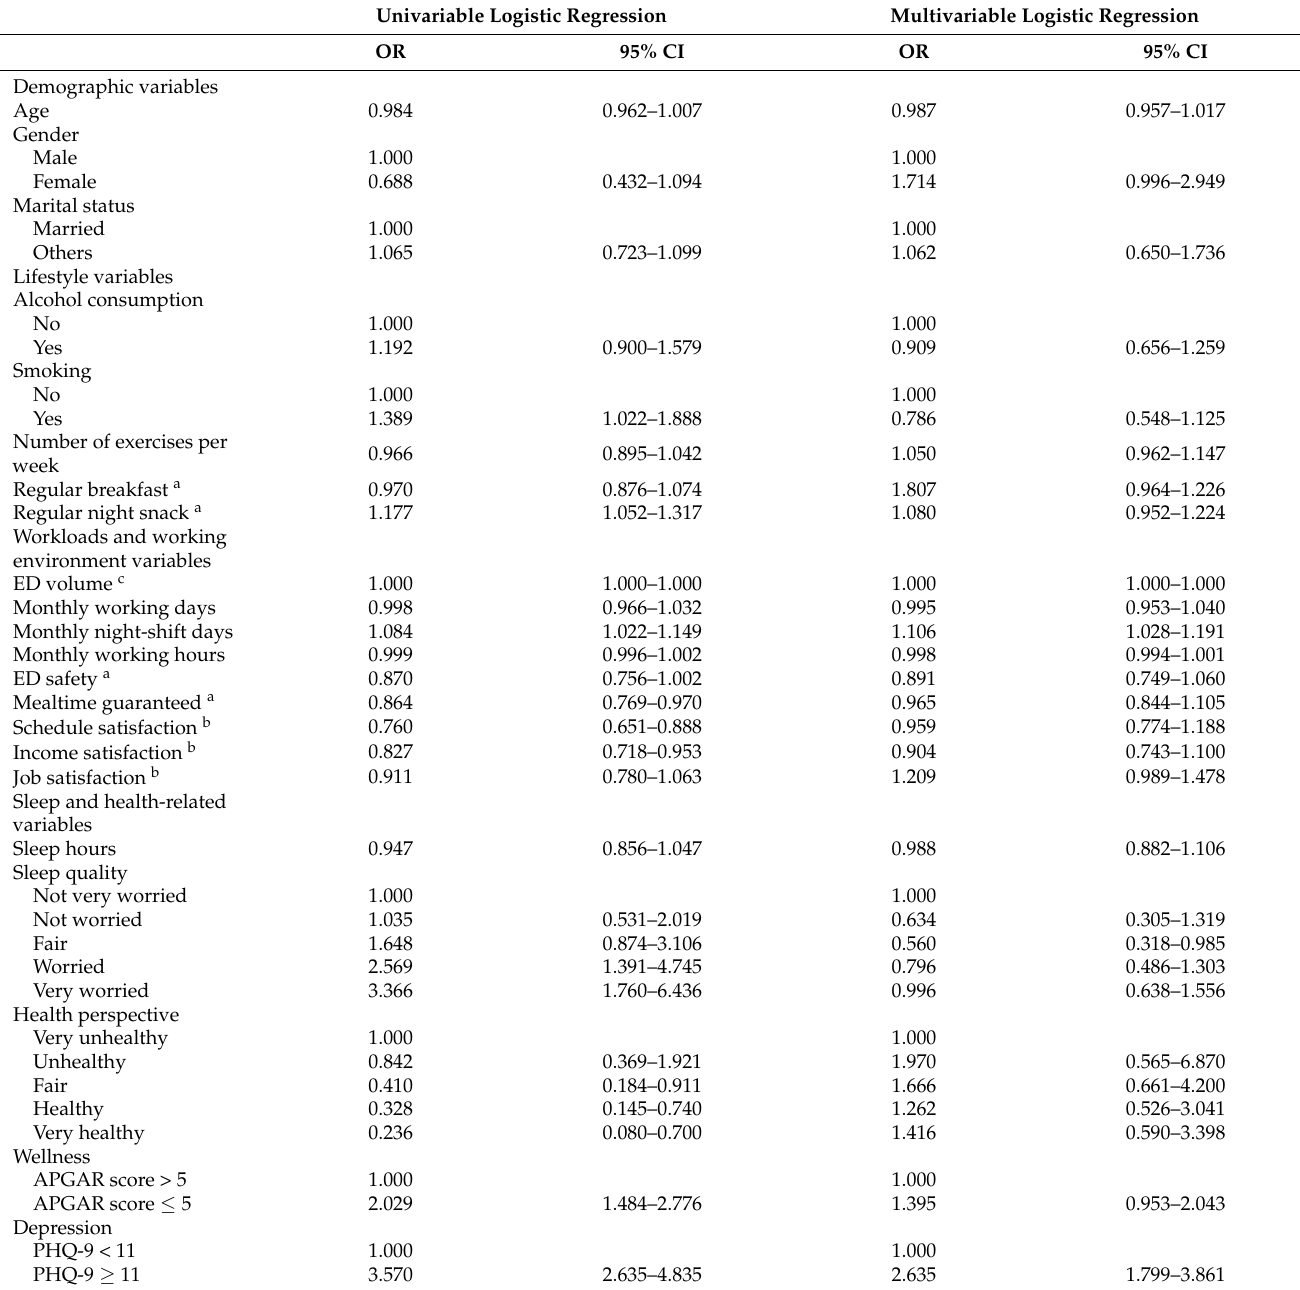
Table 2. Factors associated with